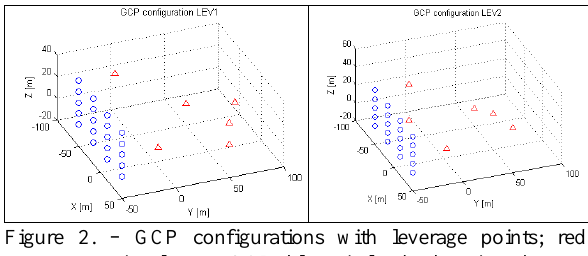
Table 3. – Results of reliability analysis.